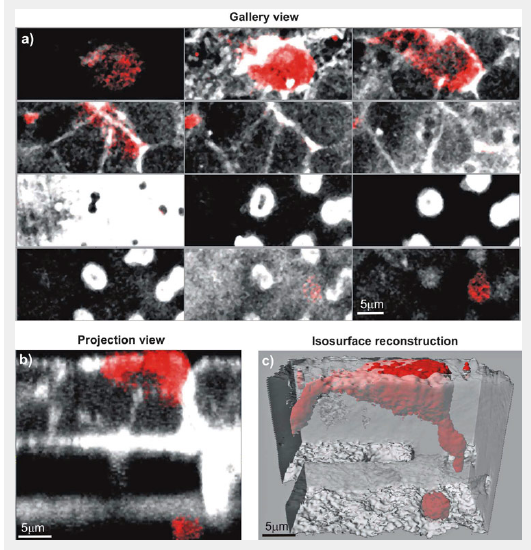
Visualisation modes of LSM 3D data stacks. Epithelial cells (16HBE14o-) and MDM were co-cultured, fixed and stained for F- actin (Phalloidin-rhodamine, white). Additionally, the MDM were stained for CD14, a specific surface marker (red). The cultures were observed with a Zeiss 510 Meta laser scanning microscope at a Z-interval of 0.3 µm, resulting in total 70 layers. Various visualisation modes using the IMARIS software from Bitplane AG are presented to show the spatial arrangement of the MDM and the epithelial cells. a) Gallery view, showing every 8th layer, b) Projection view across the xz-axes, c) an iso-surface rendering with a transparent